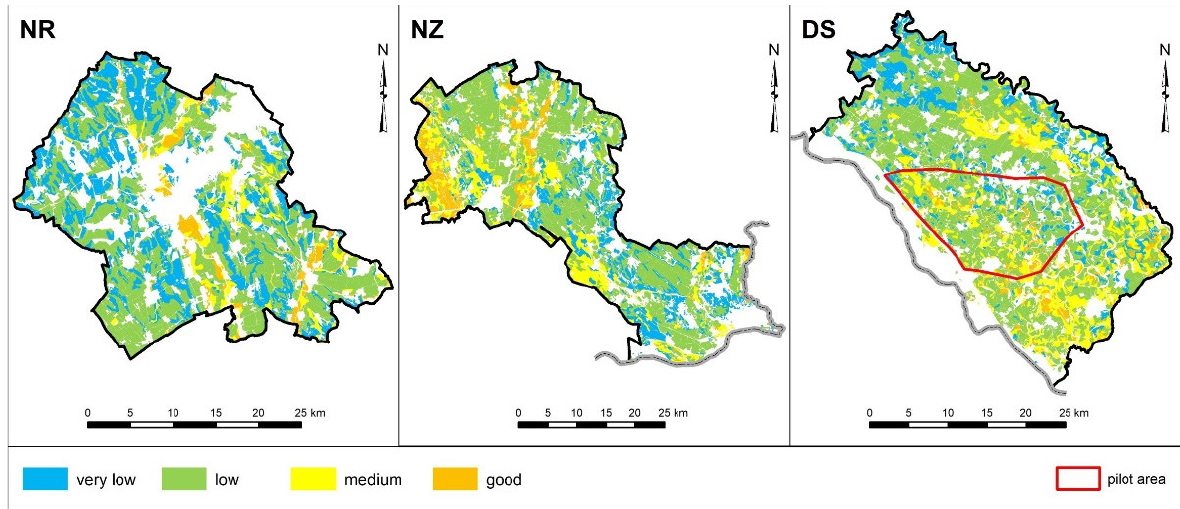
Figure 4. Maximum annual denitrification rate within UAL of selected districts.